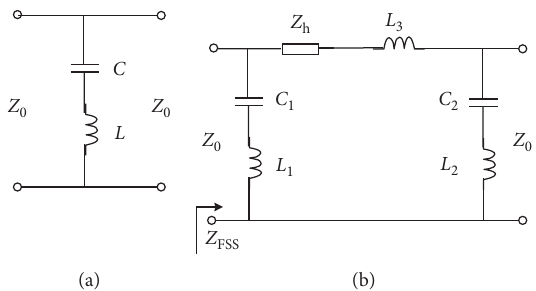
Figure 2: Equivalent circuit models of the FSS unit cells: (a) the single-layer FSS; (b) the double-layer FSS.